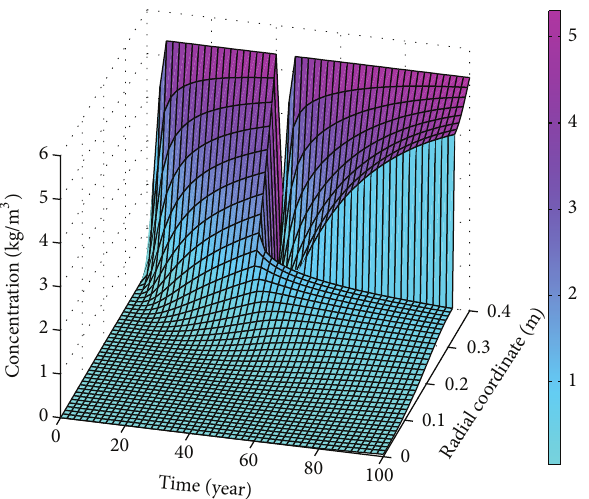
Figure 9: The evolution of chloride concentration under the same simulation condition as that of Figure 6, except that the sealer was appliedattheminimumcoverdepth(80 mm).Thesealerapplication is instantaneously followed by a concrete cover replacement.